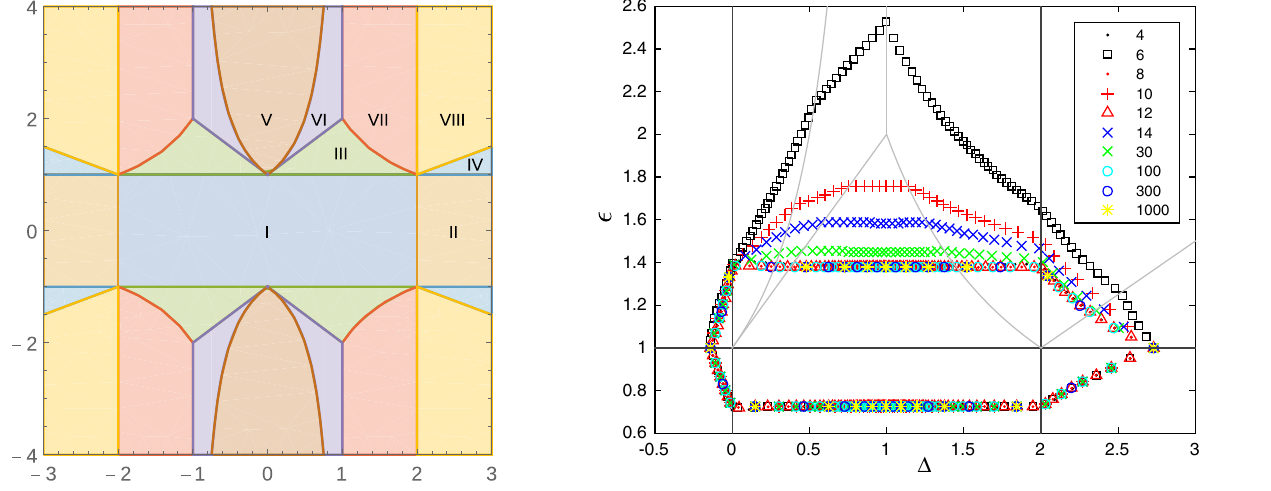
FIG. 7. The classical bound of Eq. (85). Each region [cf. Eq. (86)] has a different expression for the classical bound [cf. Eqs. (87), (88)]. The classical bound of Eq. (85) depends only on the absolute values of ϵ and Δ .